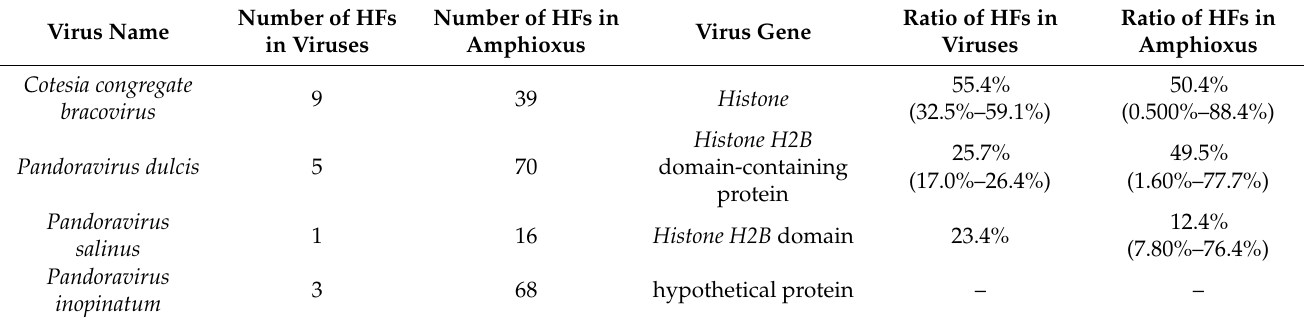
Table 2. HFs in histone genes of amphioxus.